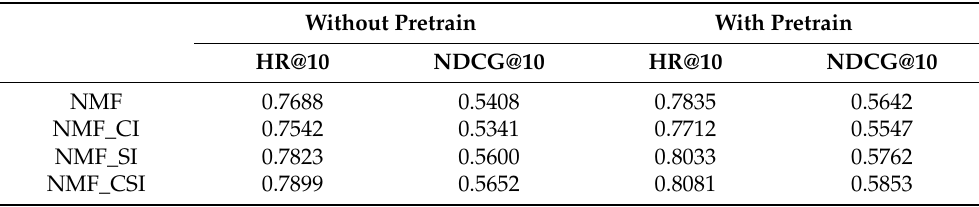
Table 6. Results according to whether Pretrained Model is used or